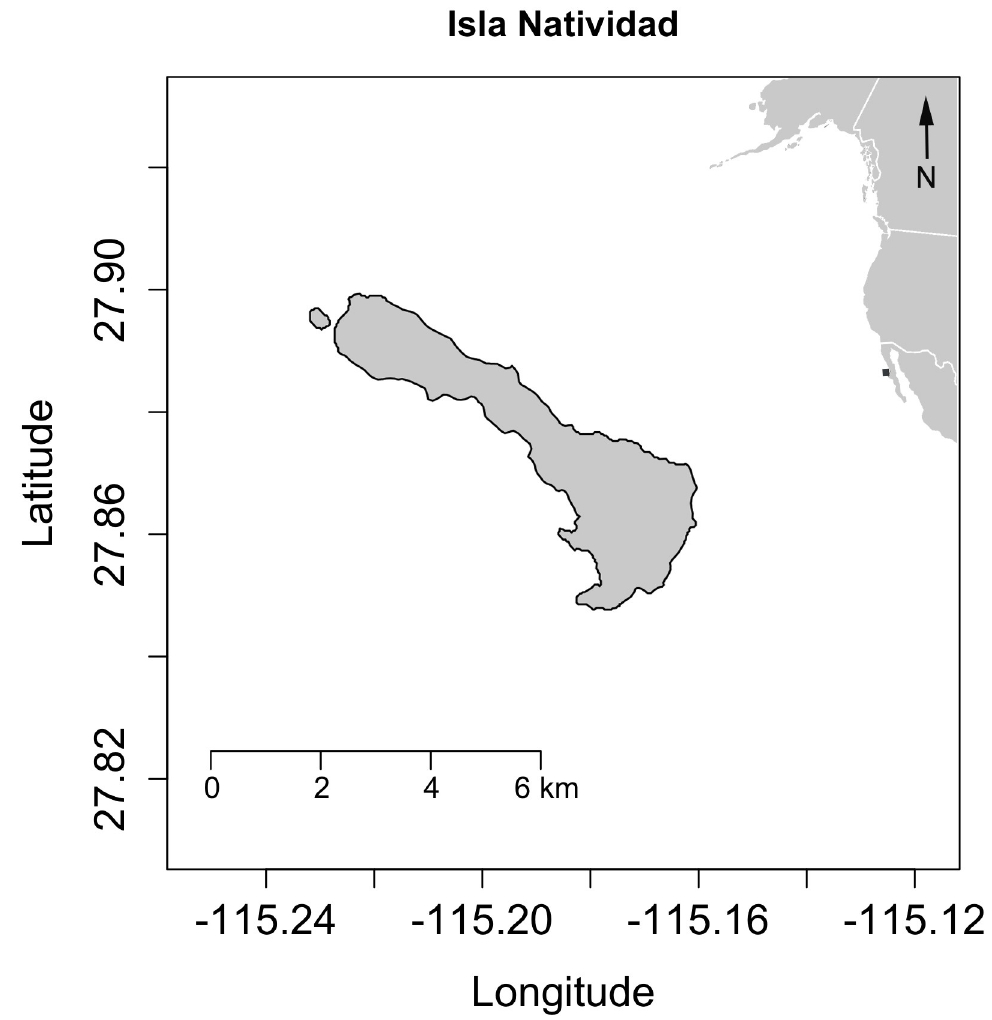
Fig 1. Map of Isla Natividad off the coast of North America. The map was generated with r package "raster" License: CC BY-SA 4.0 https://github.com/rspatial/rspatial-raster-web.